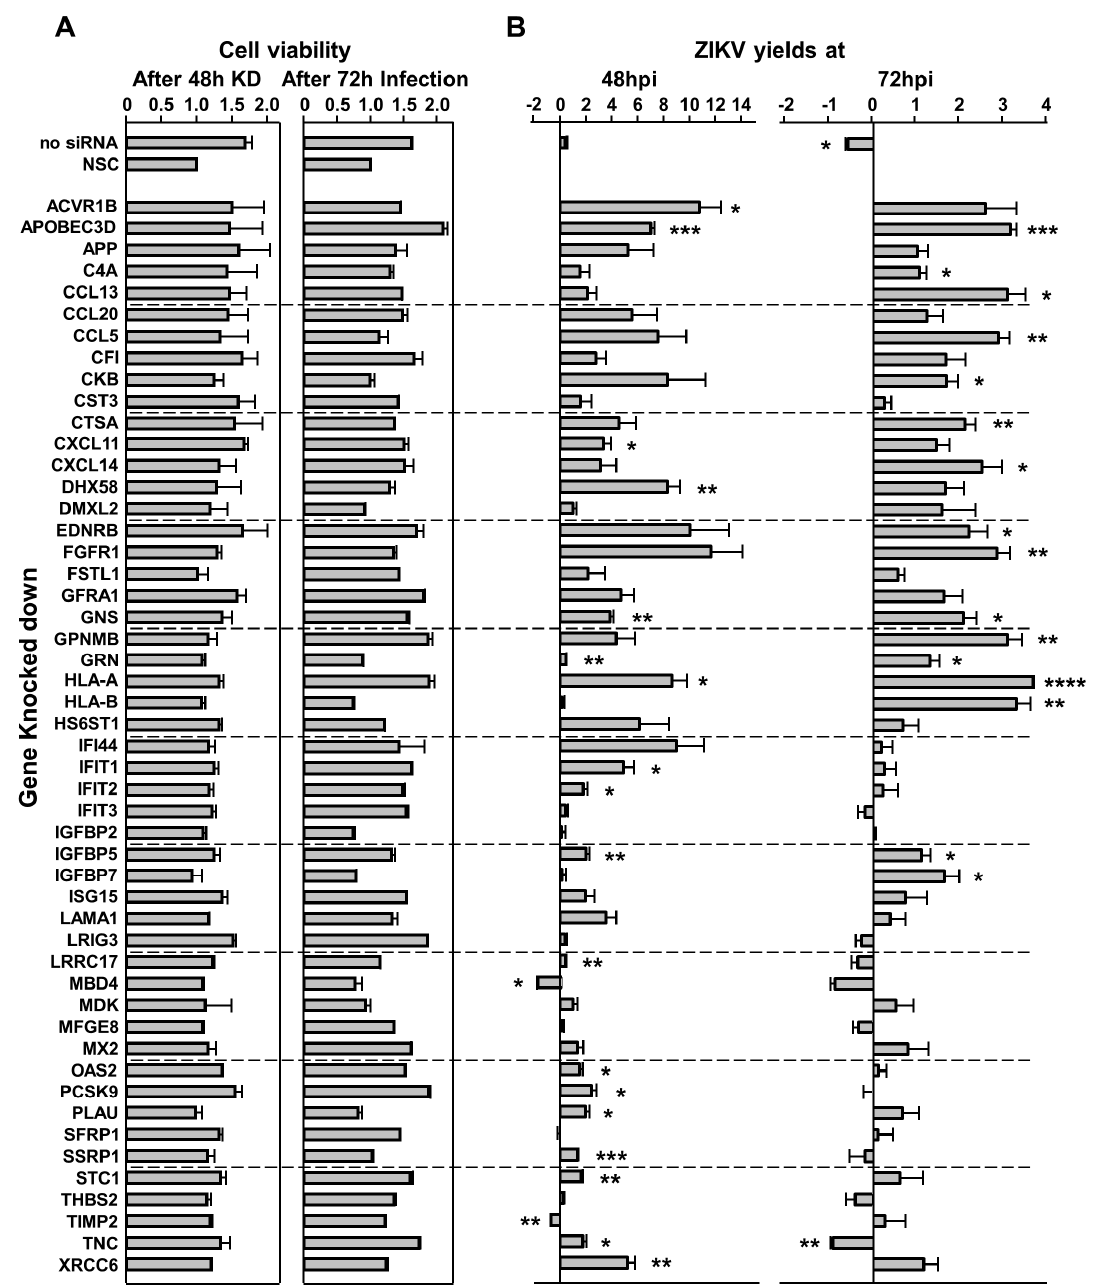
Figure 5. Effect of U251 gene knockdown (KD) on cell viability ( A ) and ZIKV yields ( B ). Cells were treated with 80 nM of the indicated siRNA (left). ( A ), Cell viabilities determined by WST − 1 assay at 48 h post − siRNA treatment without ZIKV infection (left) and after an additional 72 h after ZIKV infection (right). ( B ) , ZIKV yields from indicated KD cells at 48 (left) and 72 hpi (right). Cell viabilities and ZIKV yields are compared to those in U251 cells treated with non-silencing scrambled control (NSC). Error bars show standard deviation. * p -value < 0.05, ** p -value < 0.01, *** p -value < 0.001, **** p -value < 0.0001.